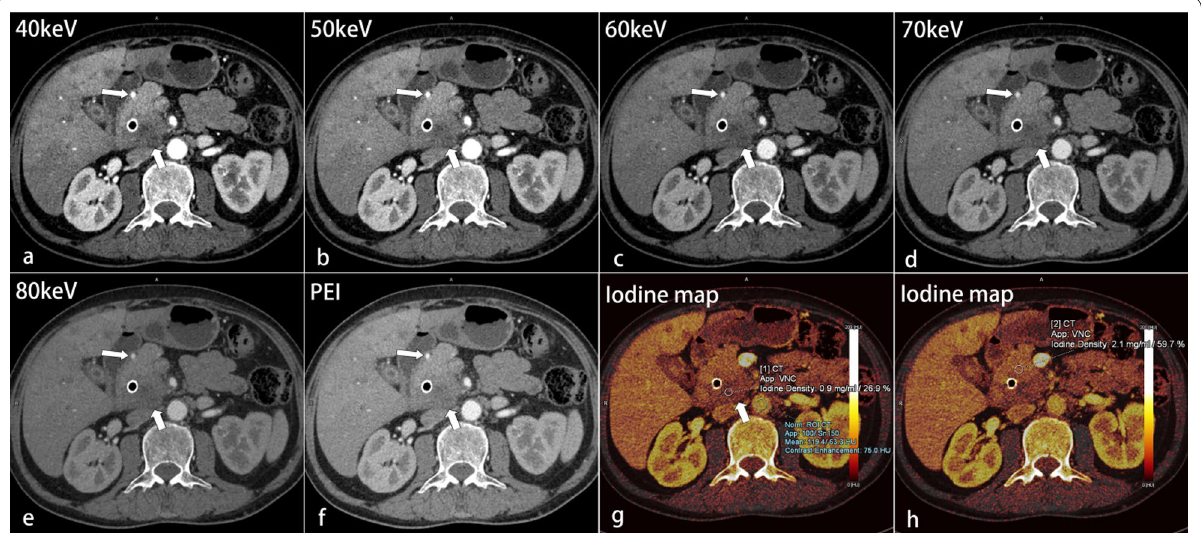
Fig.4 Transverse contrast‑enhanced images of a 62‑year‑old man with hypoattenuating pancreatic ductal adenocarcinoma (PDAC) at the uncinate process of the pancreas (thick arrows) after bile duct stenting. The tumor conspicuity, margin delineation, and depiction of gastroduodenal artery (thin arrows) were best in the MEI ( ) at 40 keV ( a ), followed by 50–80 keV ( b – e ), and were better than those in PEI ( f ). On iodine maps, the + iodine concentrations quantified in the tumor ( g ) and pancreatic parenchyma ( h ) were normalized to the aorta (blue circle) as normalized iodine concentration (NIC). The NIC tumor value of 0.9 mg/mL was significantly lower than the NIC parenchyma value of 2.1 mg/mL